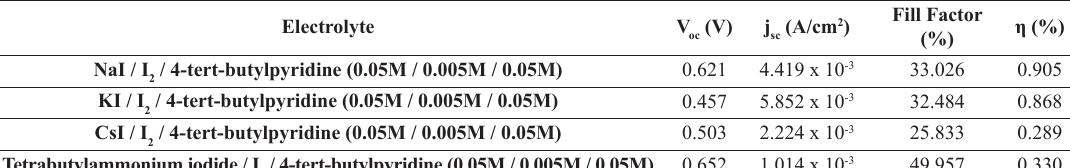
Table 10. j x V curve results of cells tested varying the iodide conter-ion in the electrolyte composition, less concentrated solutions.